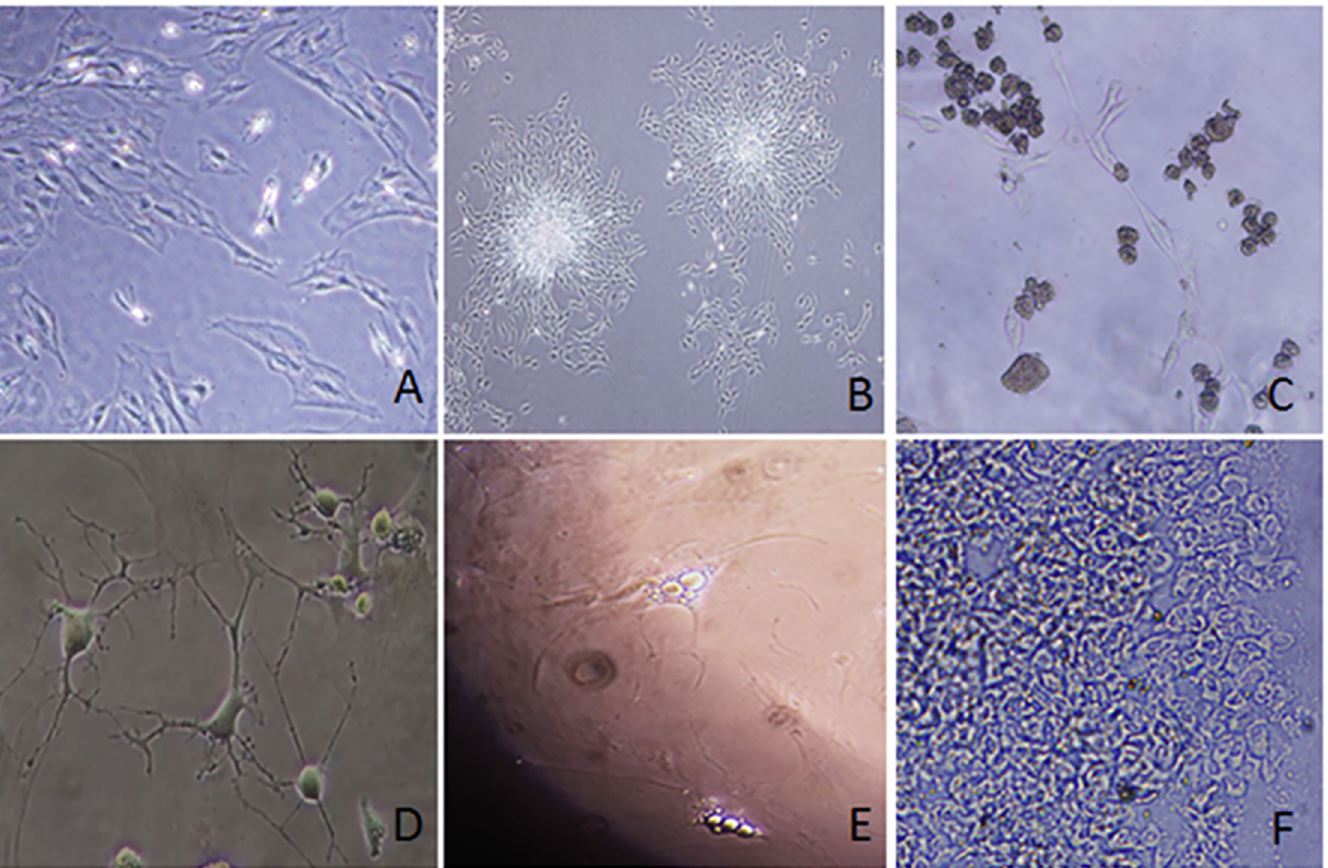
Fig 1. Multipotency of rat mesenchymal stem cells (rMSCs). Undifferentiated rMSCs (1A), forming colonies (1B) or differentiated to mTregs (1C), neurons (1D), adipocytes (1E) and chondrocytes (1F) are shown.